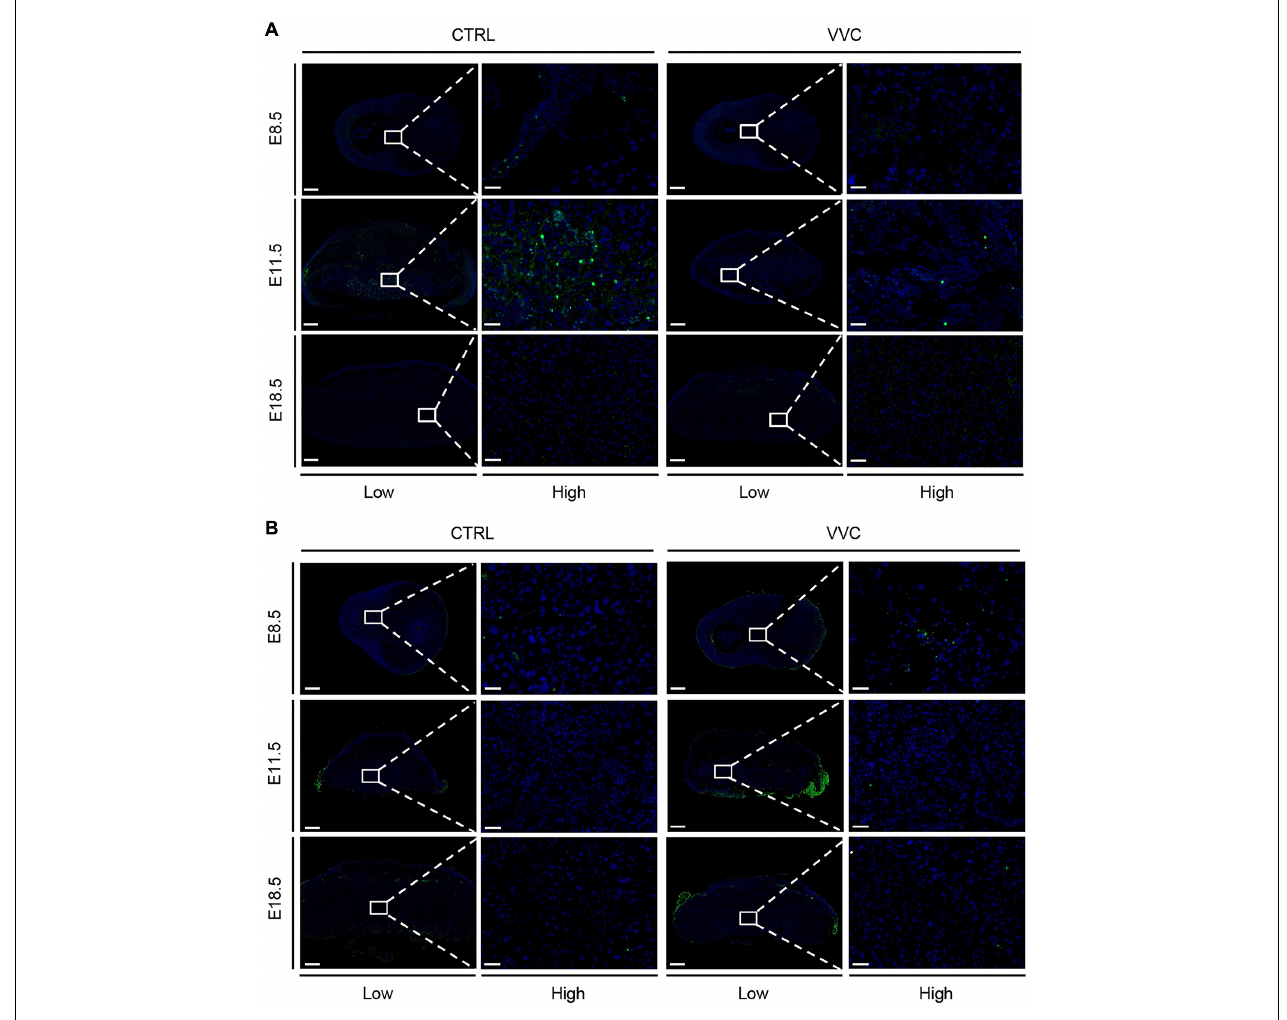
FIGURE 5 | Effect of vaginal C. albicans infection on the proliferation or apoptosis of placenta. (A) Proliferation of placental trophoblast was assessed by Ki67 staining at E8.5, E11.5, and E18.5. Five placentas per genotype were evaluated. Blue, DAPI; green, Ki67. (B) Apoptosis of placental trophoblast was assessed by TUNEL at E8.5, E11.5, and E18.5. Three placentas per genotype were evaluated. Blue, DAPI; green, TUNEL. Ectoplacental cones (E8.5) and placental labyrinth zones (E11.5 and E18.5) are presented at higher magnification. Low magnification scale bar = 500 µ m, high magnification scale bar = 50 µ m. Representative images are